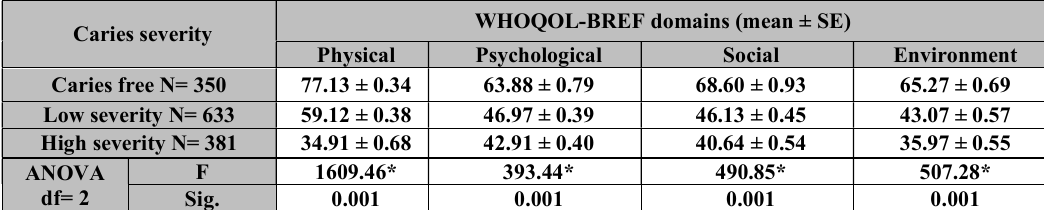
Table (2): Quality of Life Domains Score (mean and SE) according to Caries